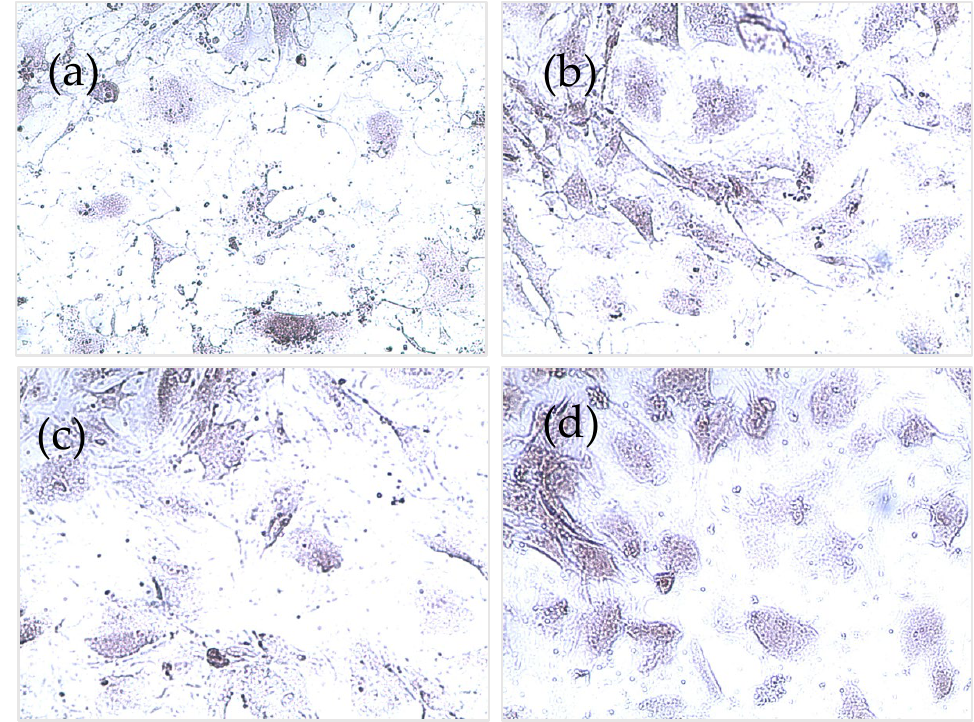
Figure 12. Alizarin red images for ( a ) cement only, ( b ) 0.3% CNT, ( c ) 1% CNT, and ( d ) 3% gentamicin-loaded CNT.